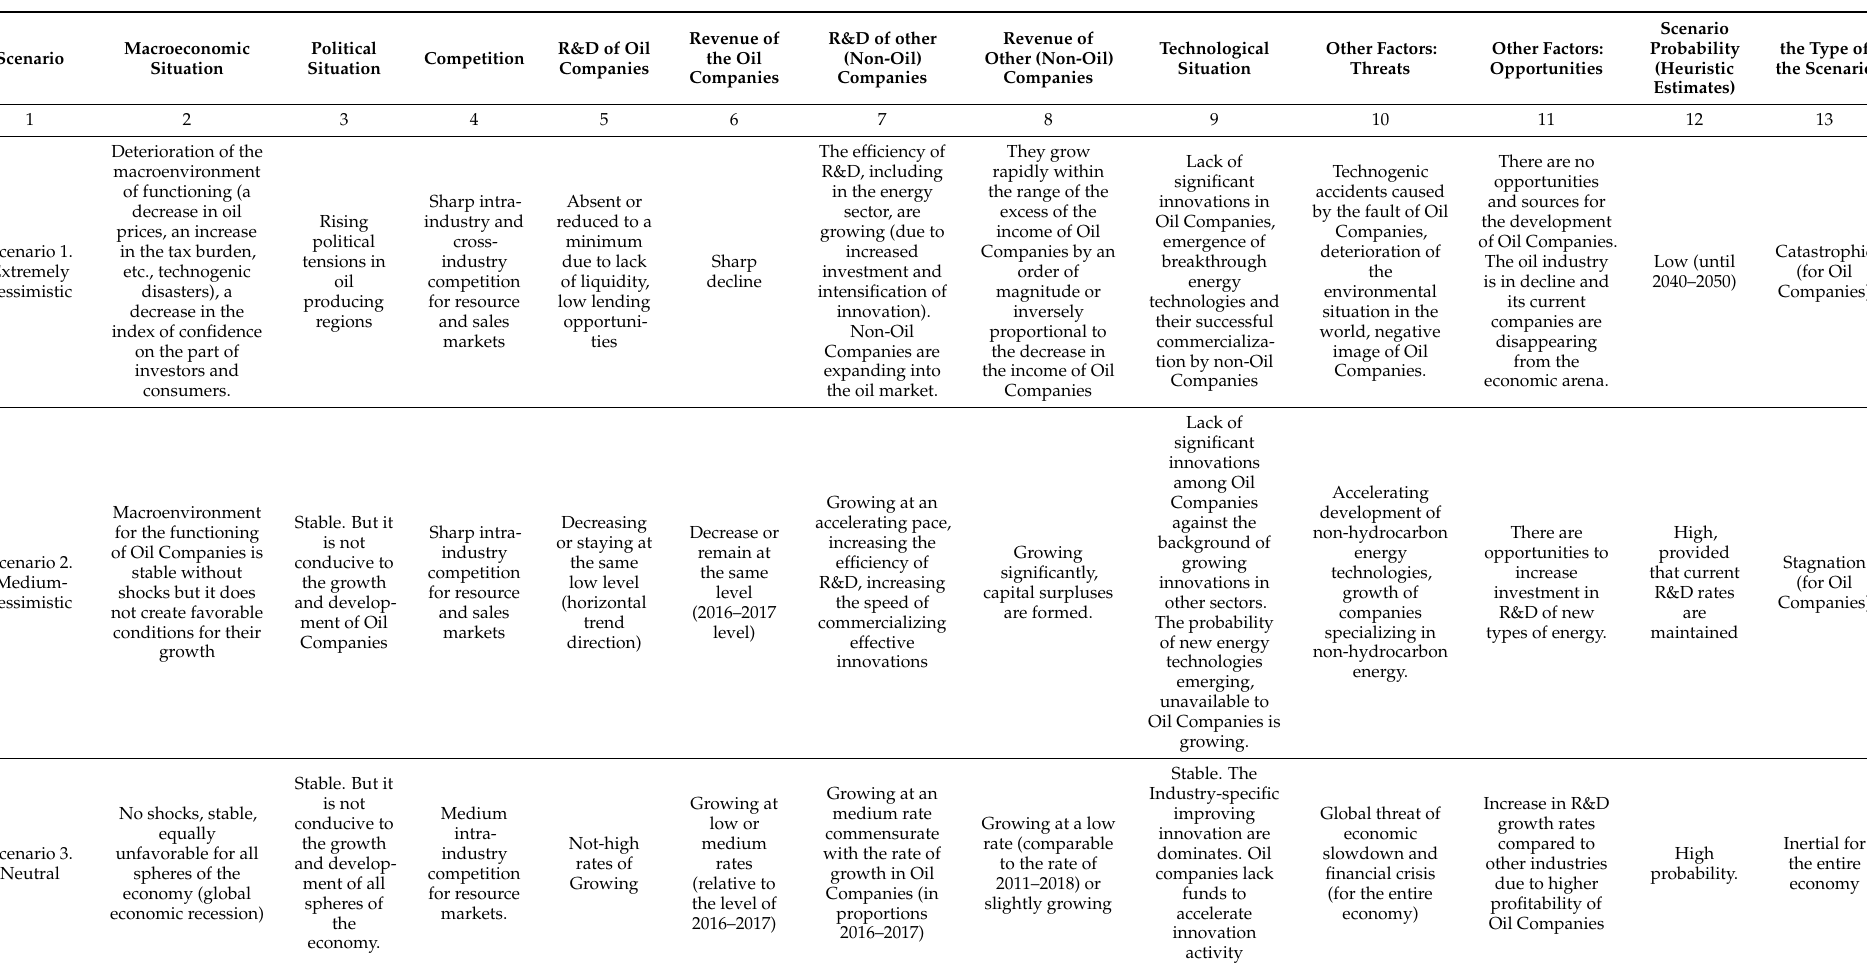
Table 2. The Scenarios of Development of the Oil Companies (Oil and Gas